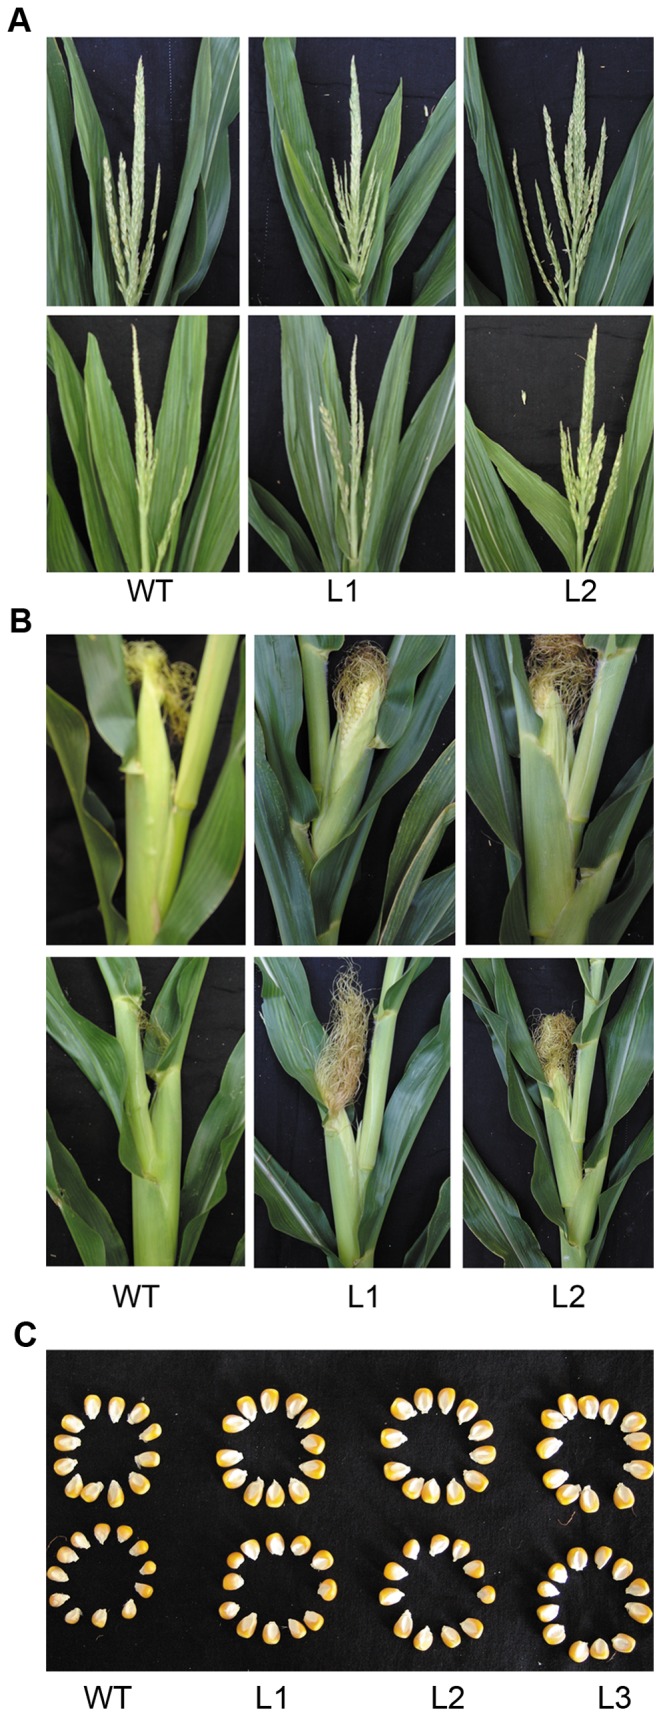
Tassels, Ears and kernels of wild type and transgenic maize plants.Transgenic plants had more tassel branches (A), larger ears (B) and kernels (C) than the wild type plants under LP conditions. WT, wild type; L1, L2 and L3 transgenic lines; SP, sufficient phosphate and LP, low phosphate.